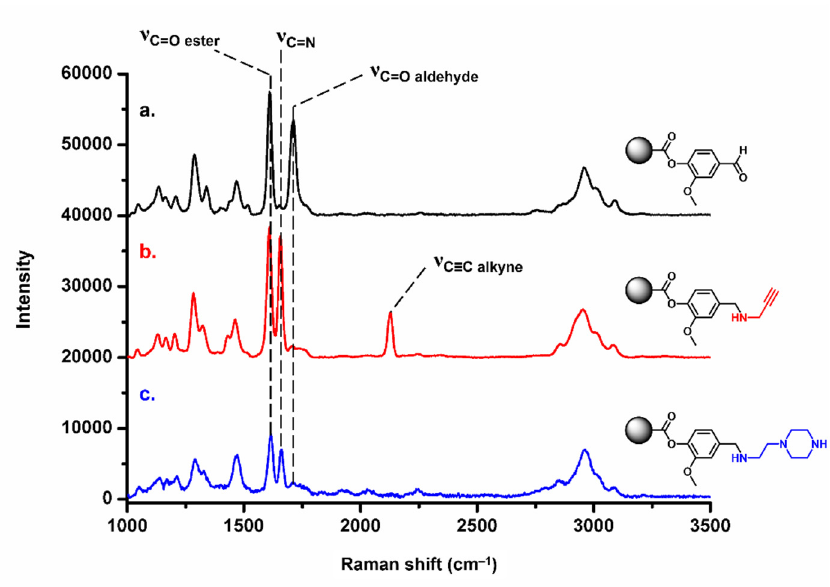
Figure 9 . Raman spectra of Poly(VMA -co- EGDMA) porous materials before ( a , black trace) and after reductive amination with propargylamine ( b , red trace) or 1-(2-aminoethyl)piperazine ( c , blue trace).